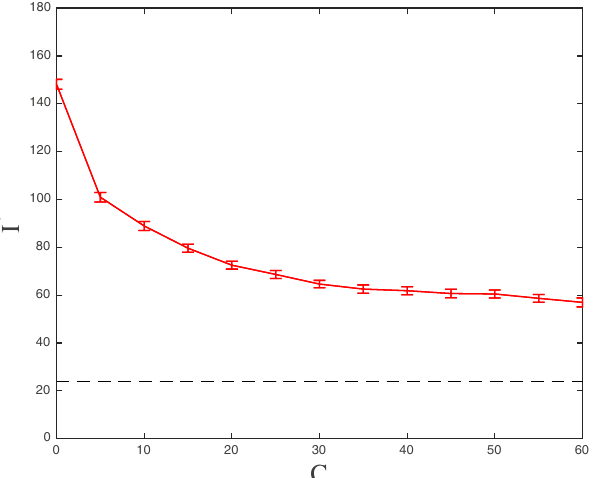
Figure 5. The mean number of infected individuals at equilibrium (and 95% confidence intervals) as a function of the number of selected nodes with the highest degrees. The dotted line shows the number of cases when all nodes are selected ( C = 953).